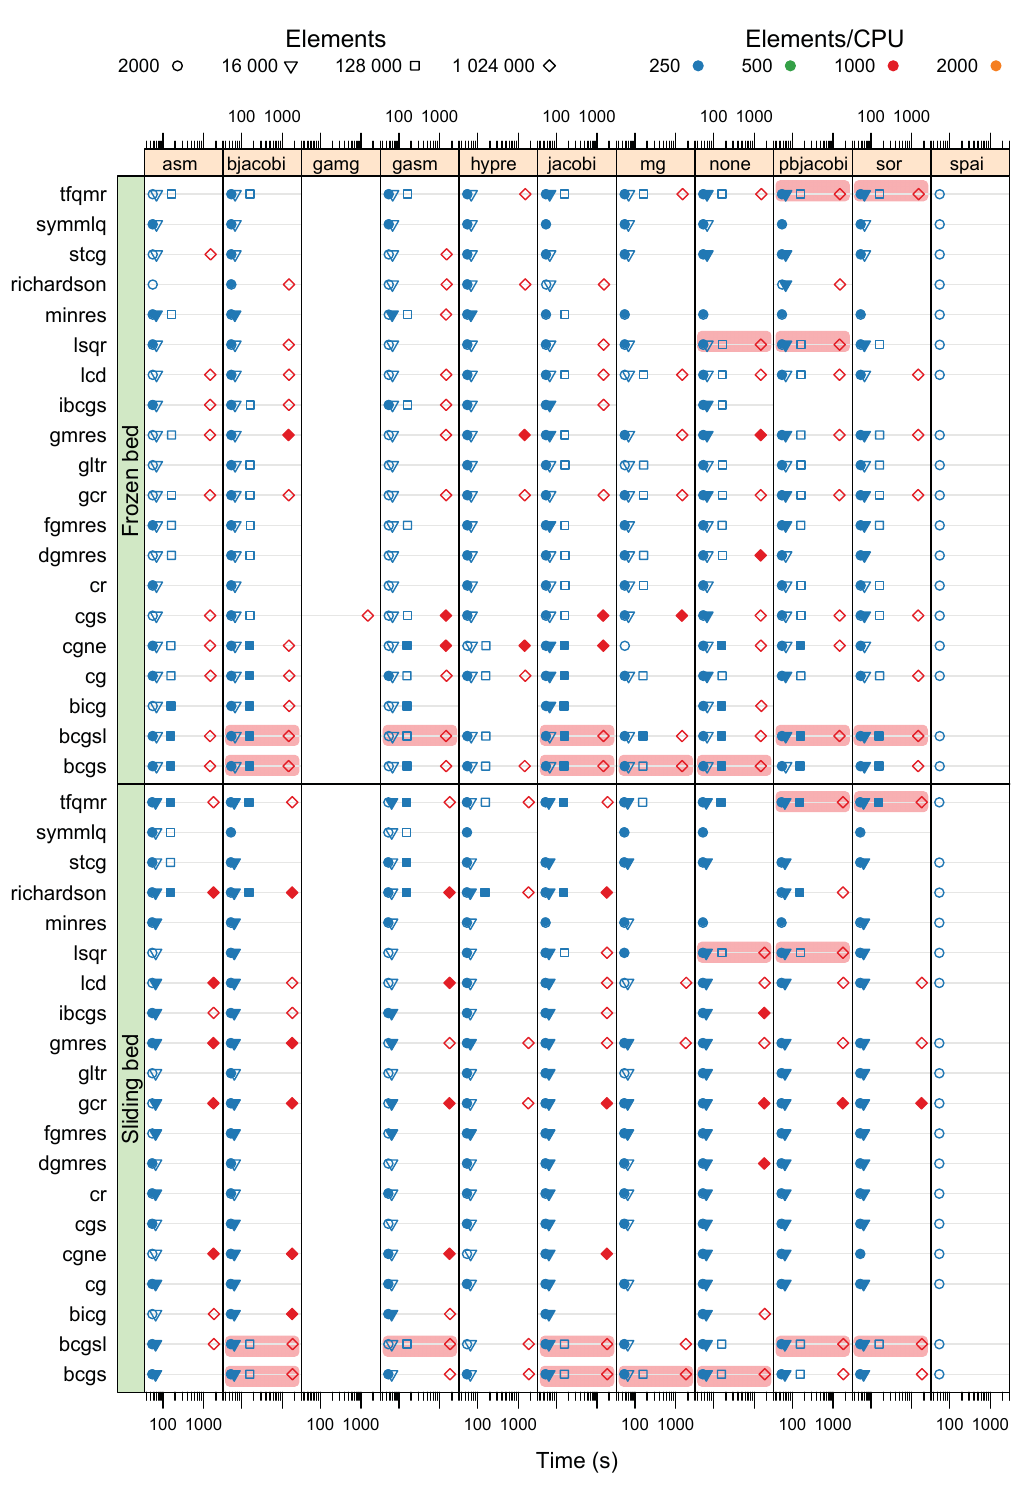
Figure 4. Mass-transport analysis: timing results for the fastest solvers (top 5%) tested on ISMIP-HOM Experiment F. The top (1%) timing results are distinguished using color-filled symbols. Red shaded boxes highlight solver combinations that rank among the fastest methods for all model sizes and both bed conditions (i.e., four symbols in the top and bottom frame). See Fig. 2 for more